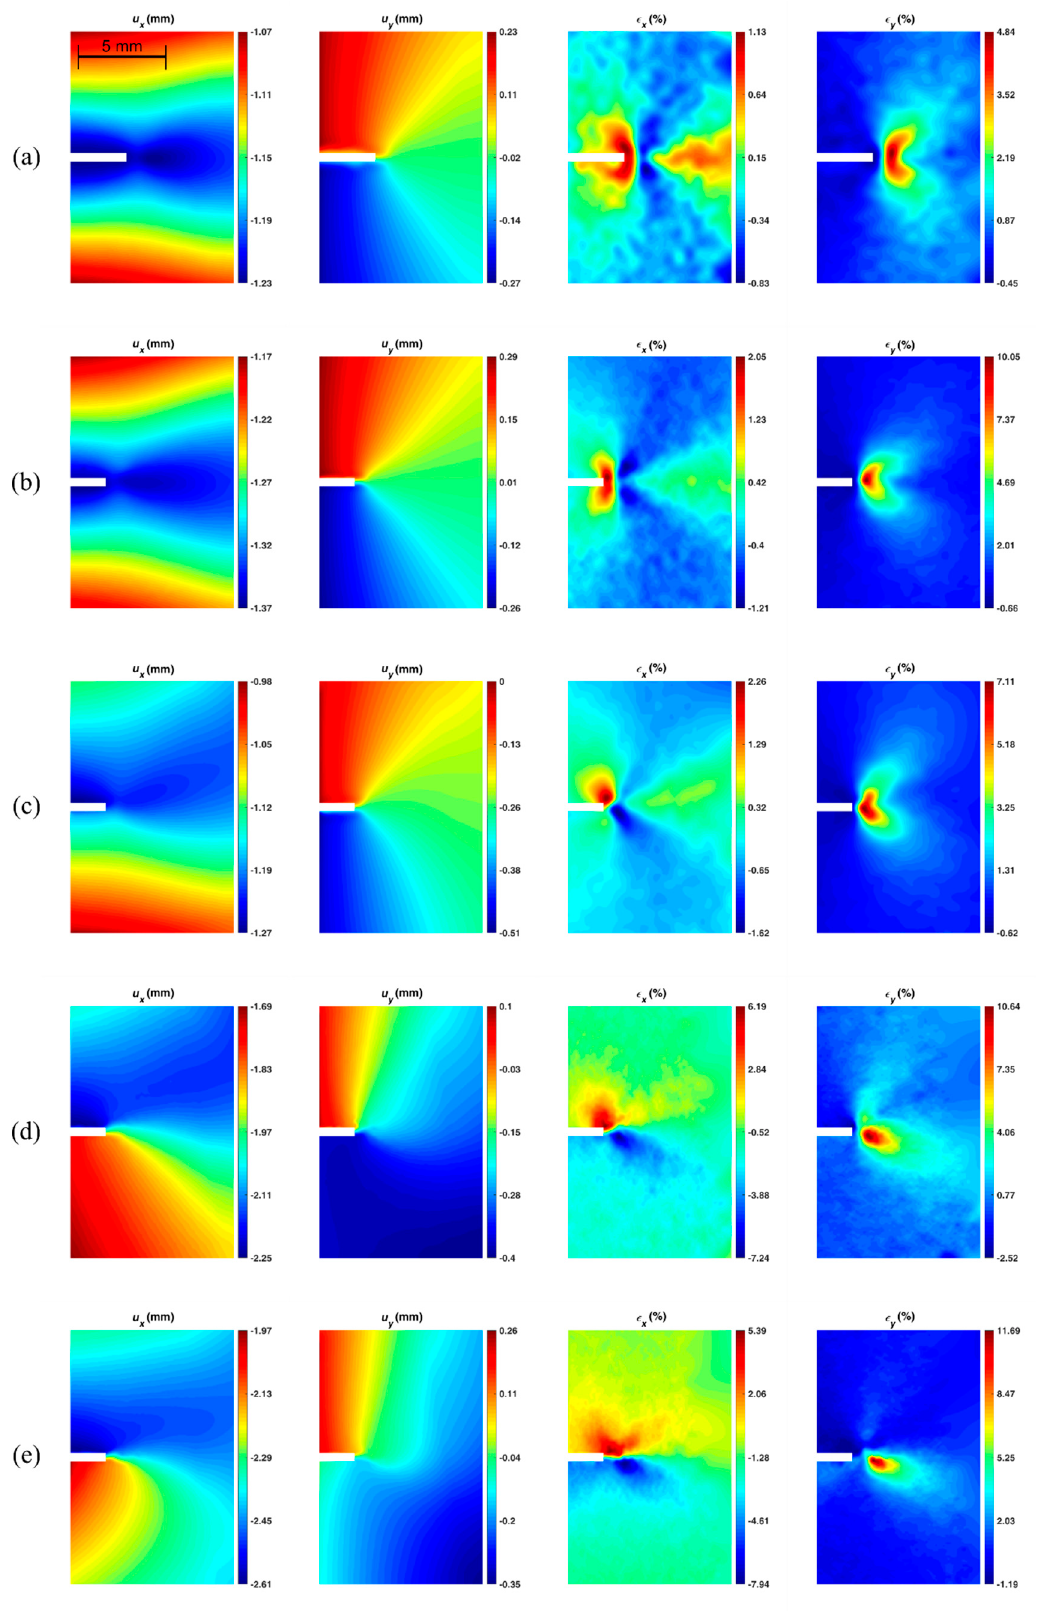
Figure 8. The x and y displacement ( u ) strain ( ε ) maps for different test configuration: ( a ) SM-0–42–42 (mode I); ( b ) AM-0–42–42 (mode I); ( c ) AM-10–42–42; ( d ) AM-10–42–18; ( e ) AM-10–42–10.2 (mode II).